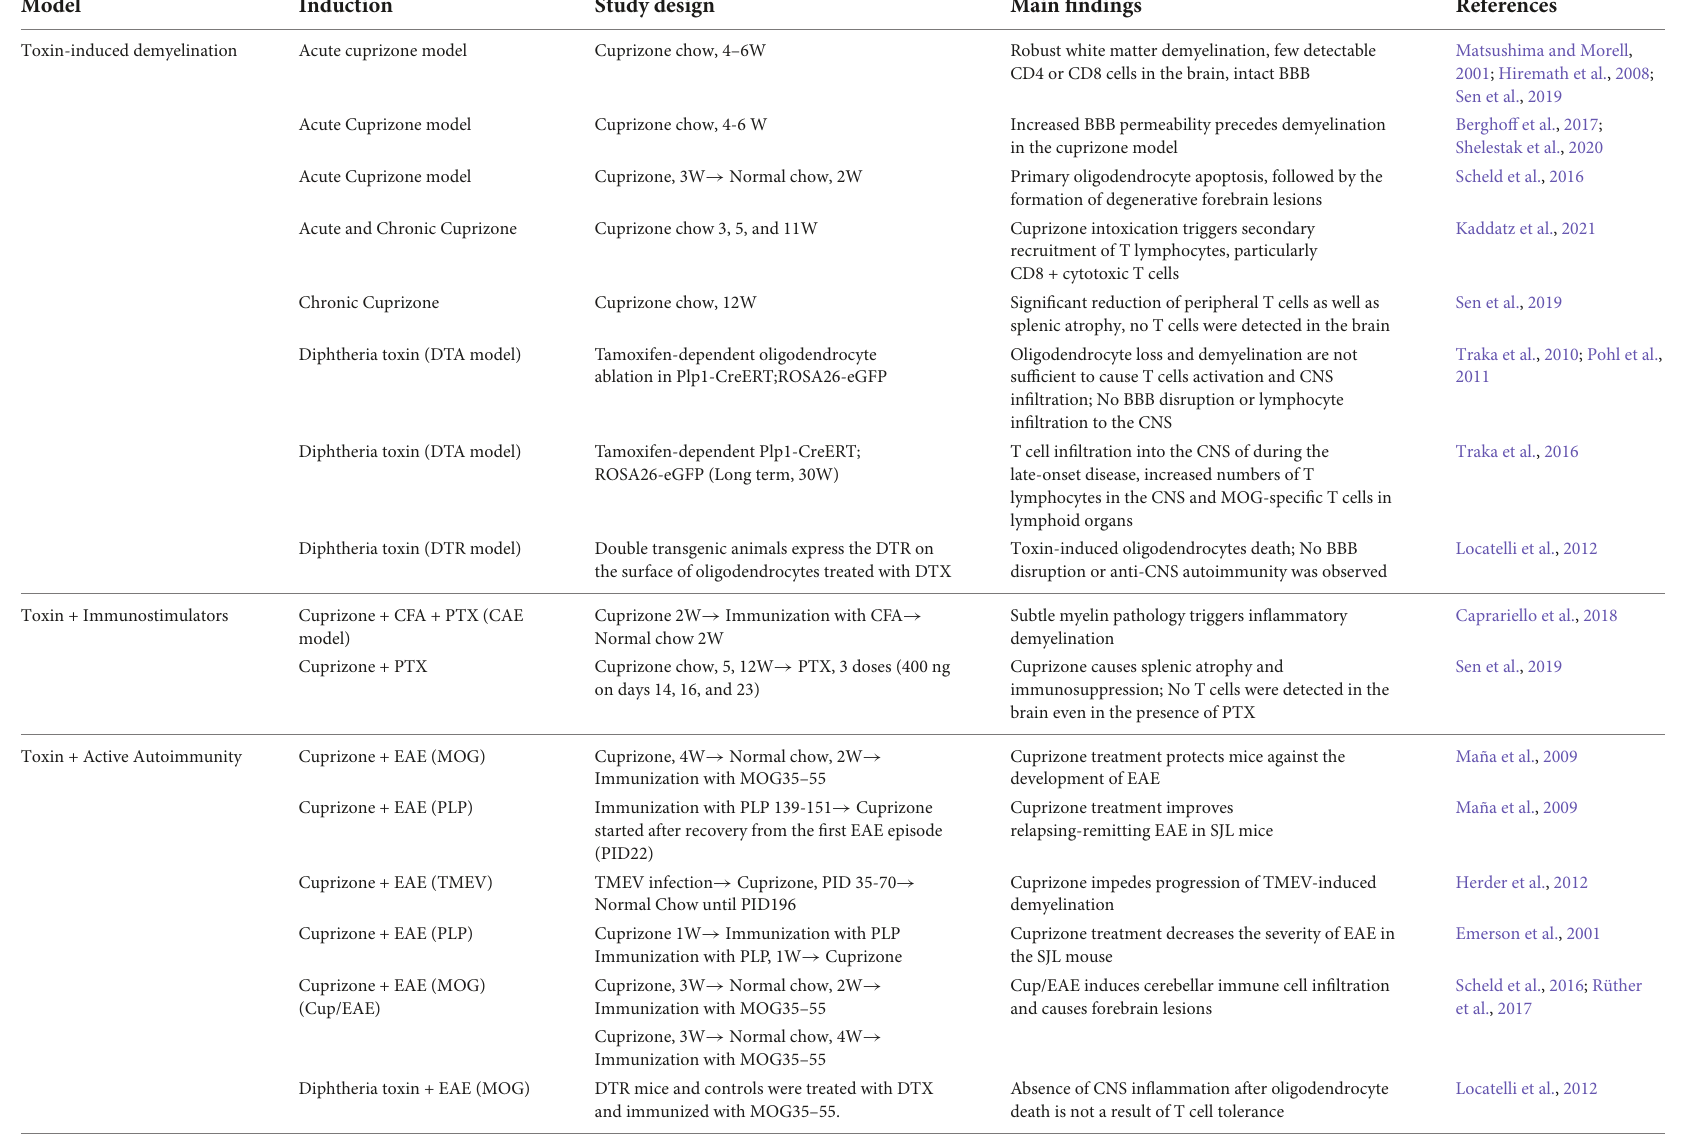
TABLE 1 Mouse models for studying inflammatory-mediated de- and re-myelination in